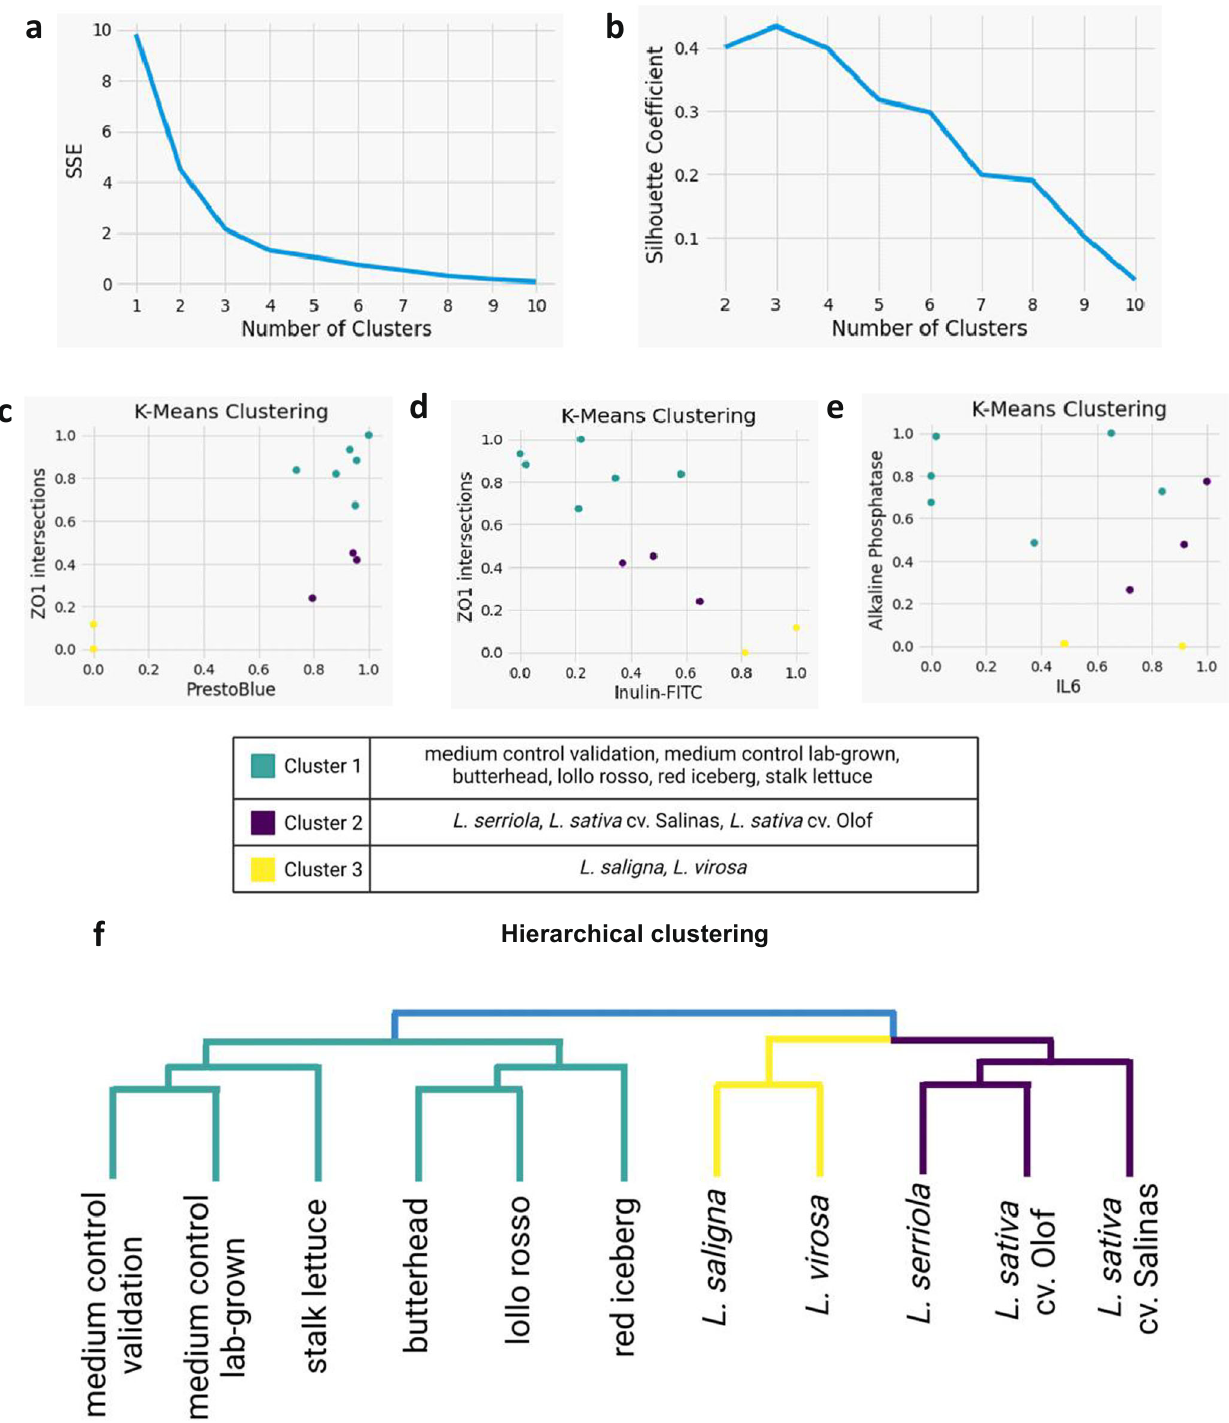
Fig. 4 Comprehensive analyses reveal distinct intestinal biological behavior of Lactuca lines at different stages of domestication. a shows the sum of squares due to error (SSE) to fi nd an optimal number of clusters. b shows the evaluation of the silhouette coef fi cient. c – e shows three different K-means visualizations of the clustering. f illustrates the results of a hierarchical clustering in the bioengineered intestinal tubule remains unclear due to the background IL-6/IL-8 measurements in the plant extracts. In future studies, additional evaluation of gene expression, correlating these to protein secretion data, in the intestinal epithelial cells can help to clarify the potential immunomodulatory properties of lettuce.